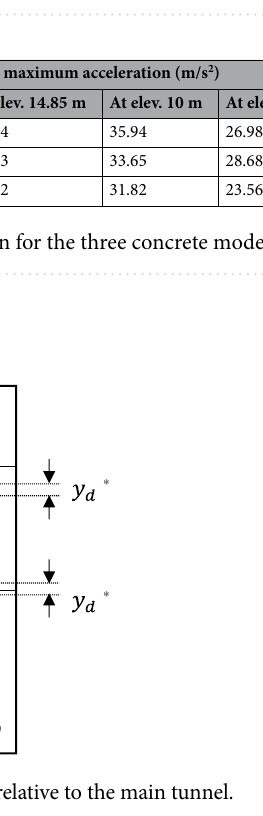
Figure 10. Pressure time histories of the transmitted acoustic wave for the models with Concrete I, Concrete II, and Concrete III as the tunnel lining concrete.